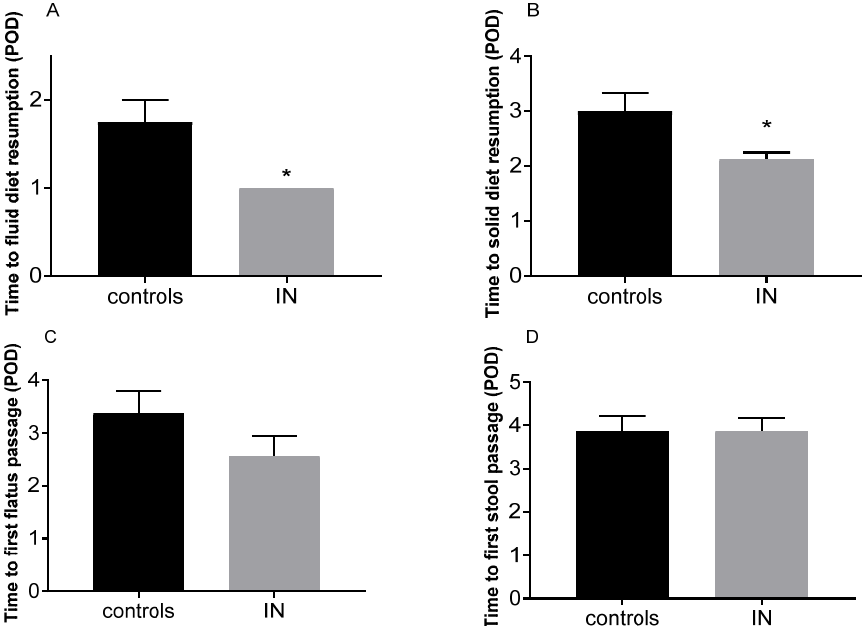
Figure 1. Mean days of postoperative (POD) fluid ( A ) and solid oral diet resumption ( B ) and time of first bowel movement, considering both the first POD flatus passage ( C ) and stool passage ( D ) in controls and in IN patients. Data are expressed as means ± SEM * p < 0.05 by unpaired t test.